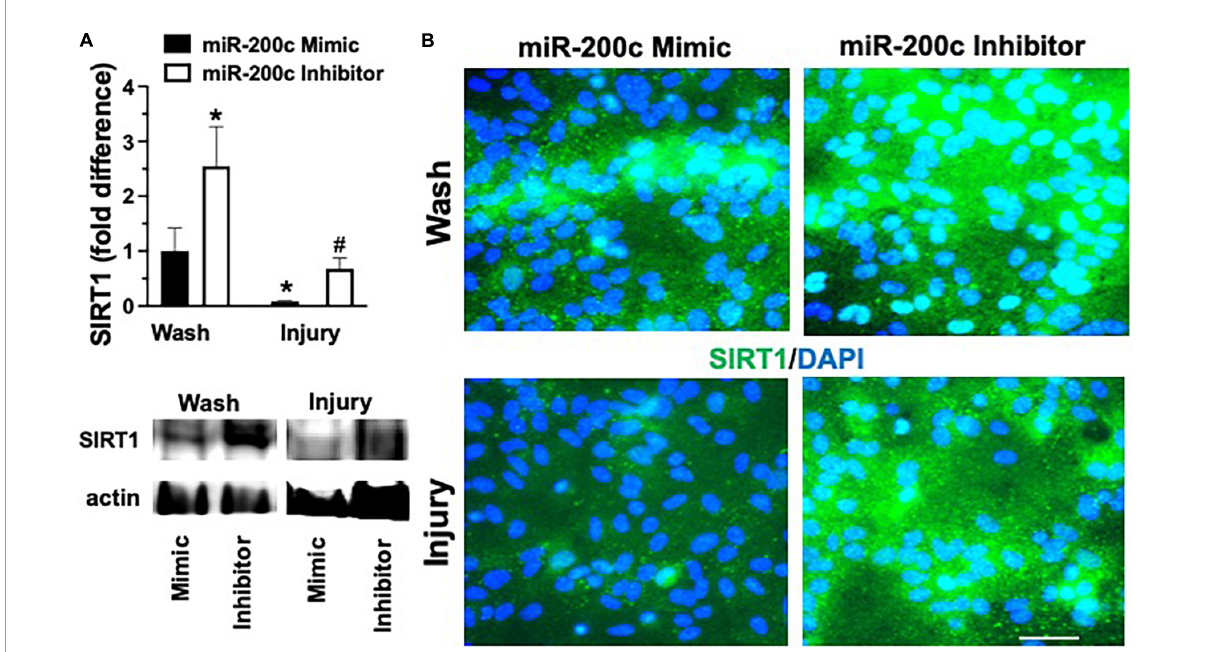
FIGURE7 Effect of miR-200c on pre- and post-injury astrocyte SIRT1 in astrocyte cultures. Quantification (A) and representative images (B) of SIRT1 fluorescence 24 h after 3 h combined oxygen glucose deprivation injury in primary cortical astrocyte cultures with miR-200c mimic or